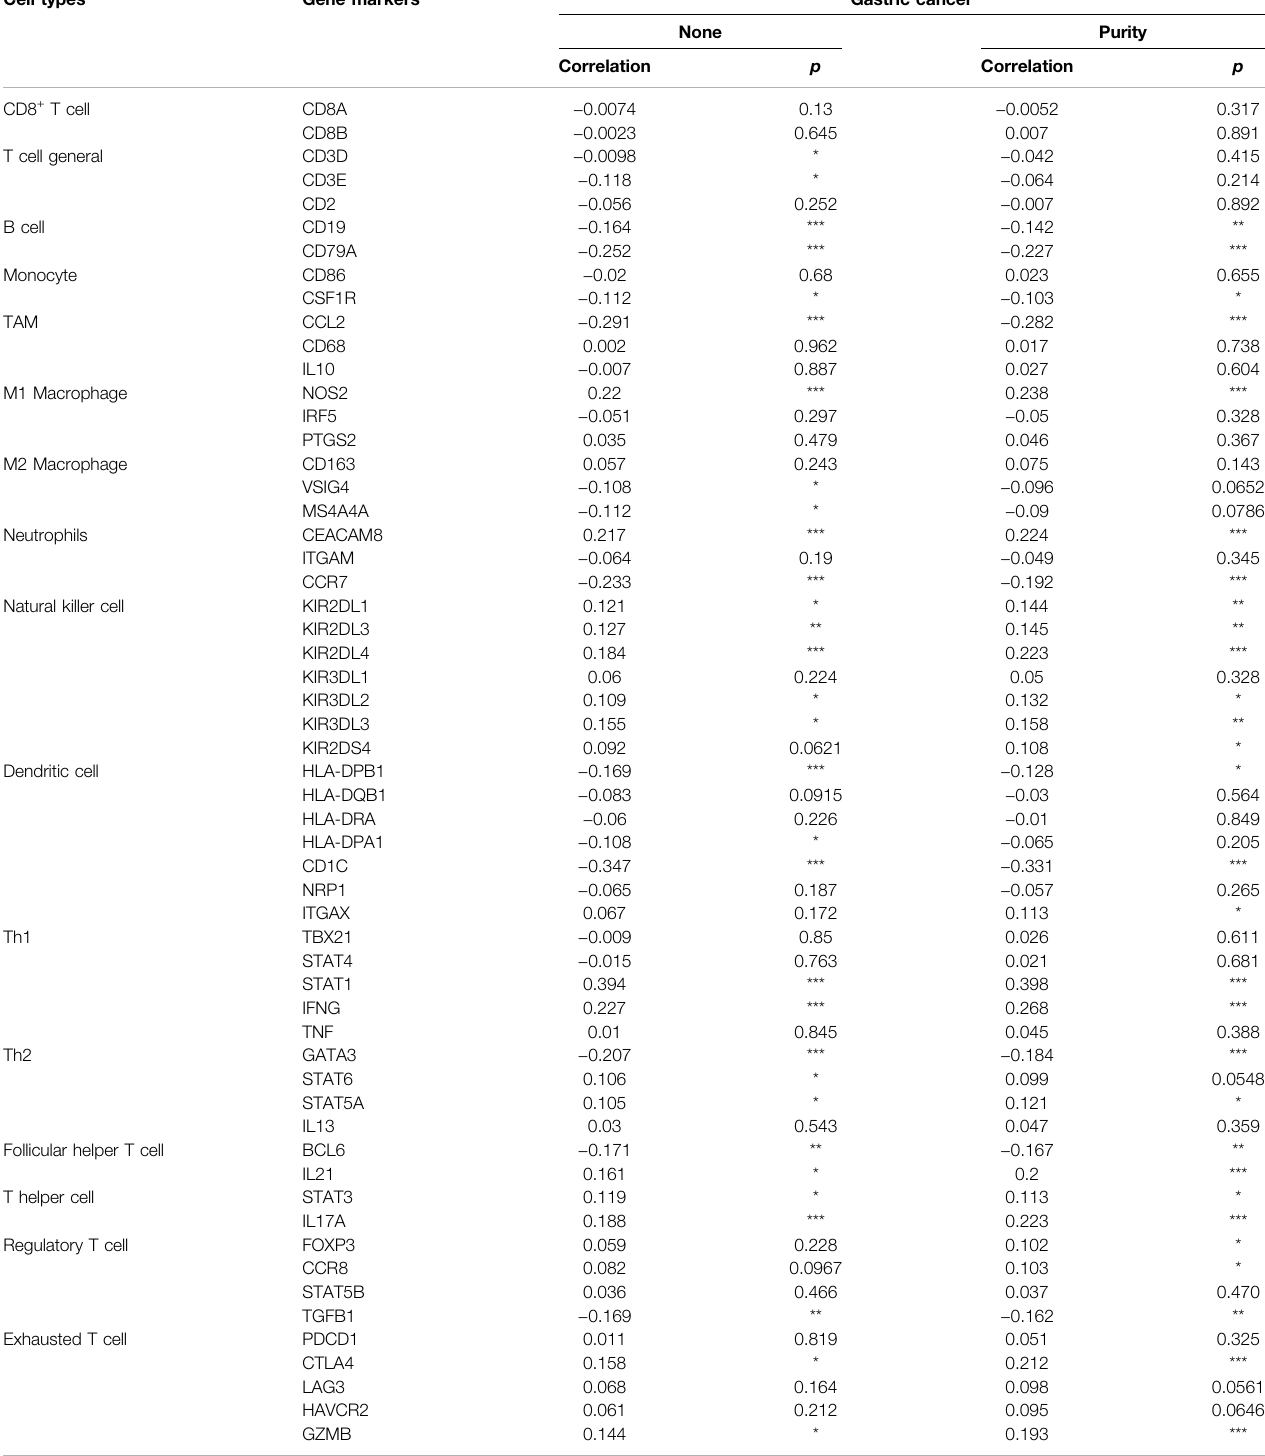
TABLE 2 | Correlation between ARHGAP11A and related immune markers in